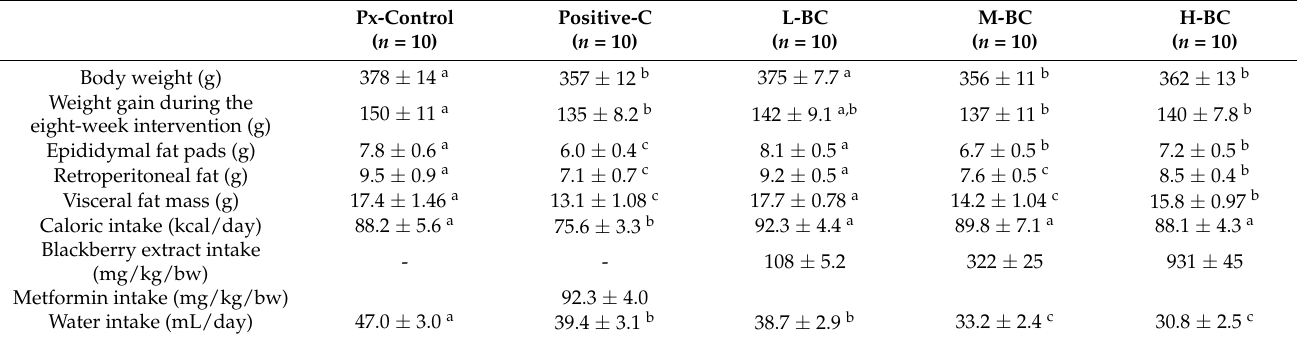
Table 1. Body weight, food intake, and visceral fat mass after the eight-week